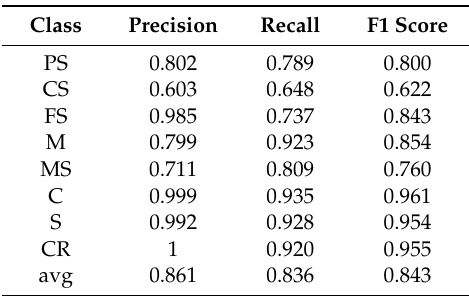
Table 3. Performance matrix of each lithology class for 5-fold-cross-validation averaged over ten runs in the